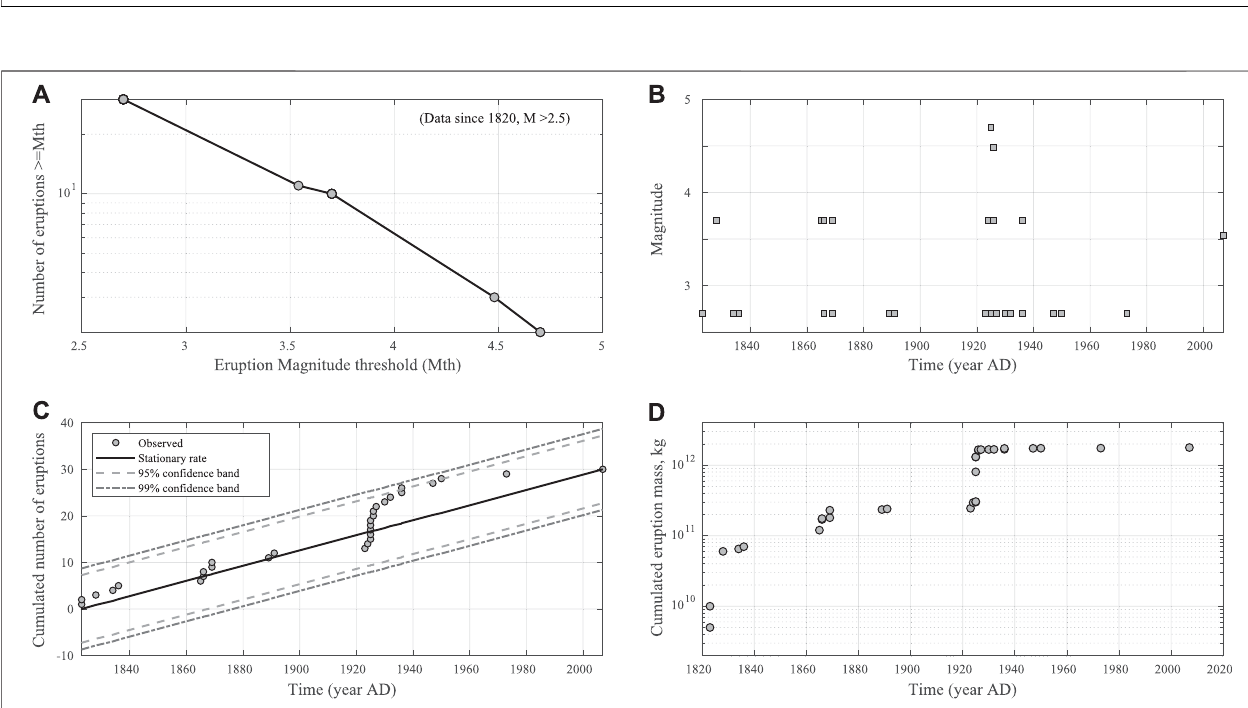
FIGURE 2 | Same as Figure 1 , for the complete part of the catalog only, i.e. only eruptions of M ≥ 2.6 since 1820AD. In panel C we also show the theoretical relationship (solid line) for a perfect stationary process, while the dashed/dashed-dotted lines show the 95 / 99 % con fi dence interval.